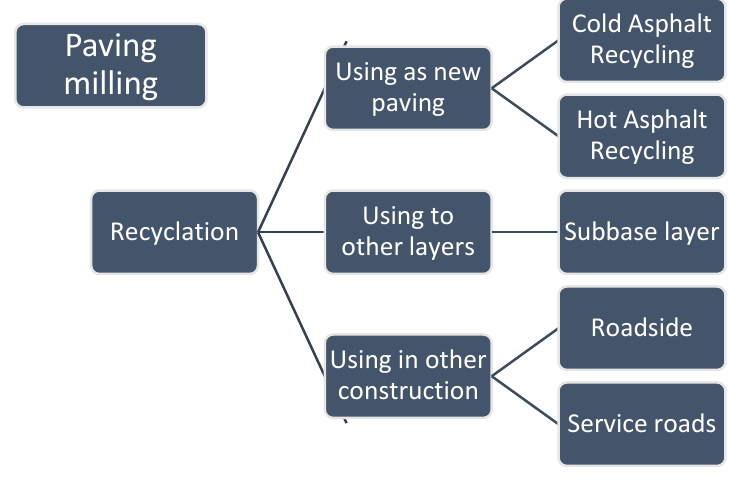
Figure 1: Methods of recycling milled